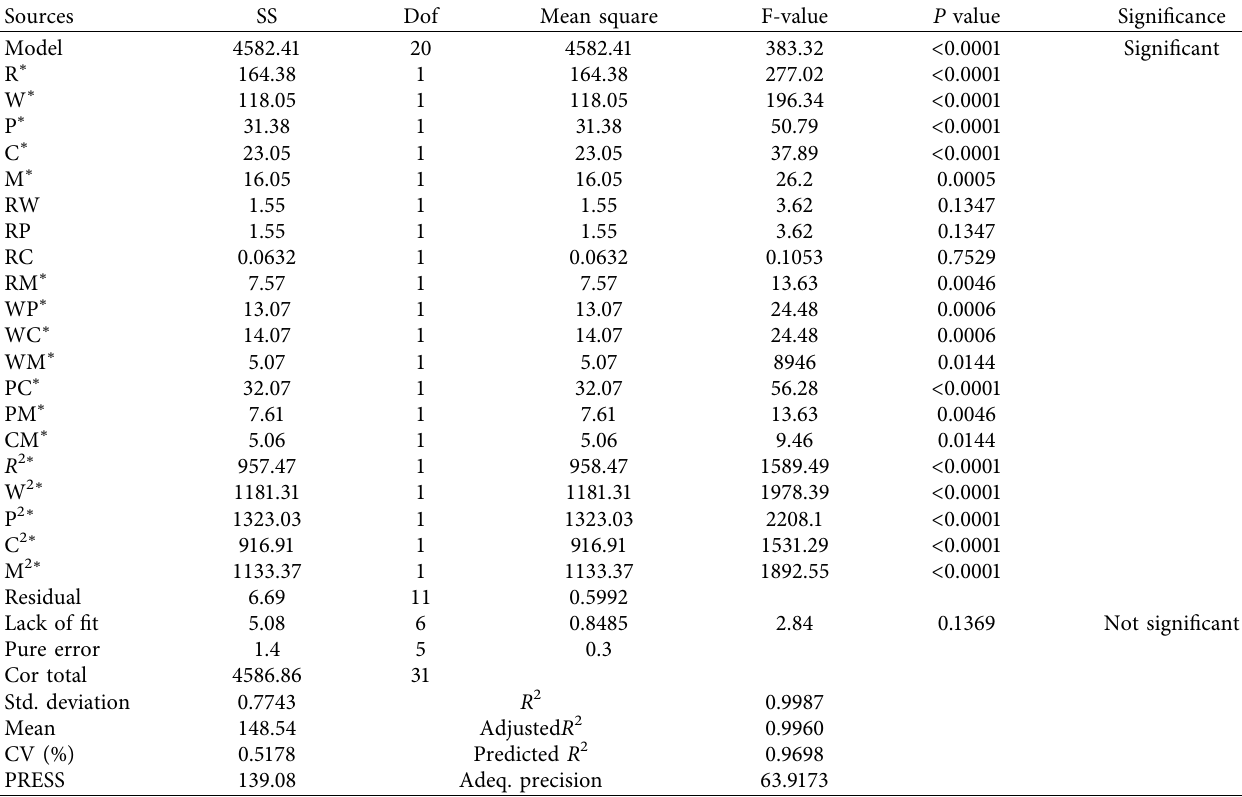
Table 6: Tensile strength ANOVA results.